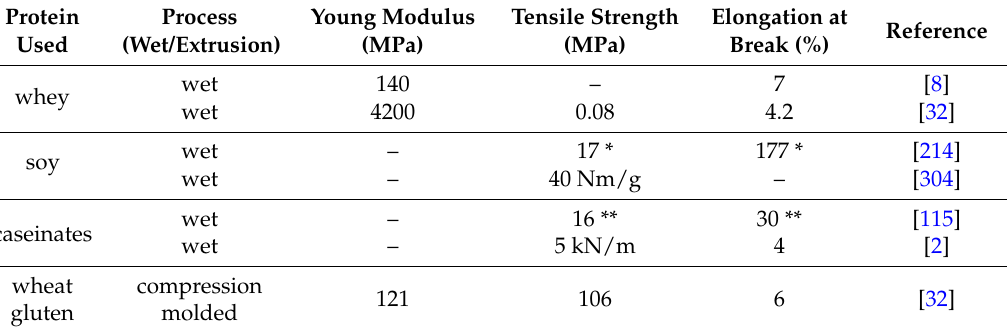
Table 7. Reported mechanical performances for coatings applied on paper based on the commonly used proteins (best value reported when number of samples were